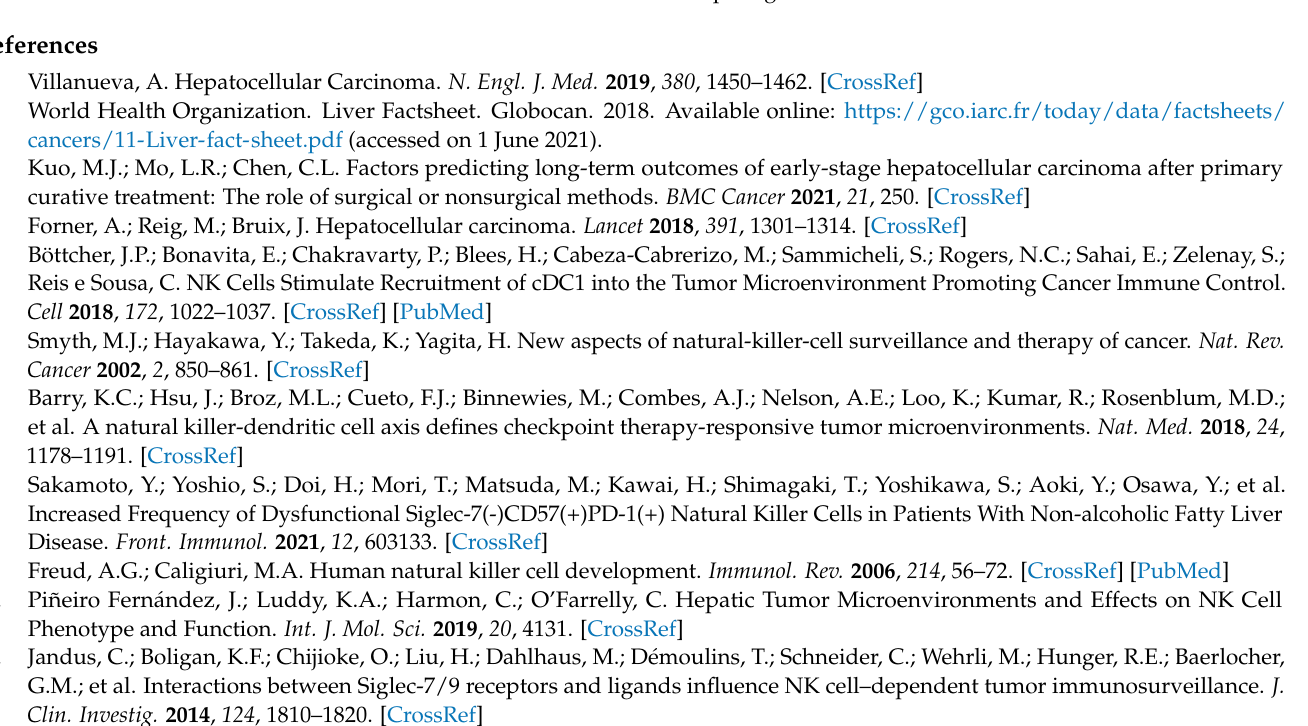
HCC patients for the analysis of the frequency of immune cells, Table S2: Clinicopathological characteristics of HCC patients for the analysis of surface markers on NK cells in Figure S2, Table S3: Clinicopathological characteristics of patients for the analysis of intrahepatic NK cells in Figures S3 and S4, Table S4: Antibodies used for mass cytometry in Figure S1, Table S5: Antibodies used for mass cytometry for the analysis of surface markers on NK cells in Figures